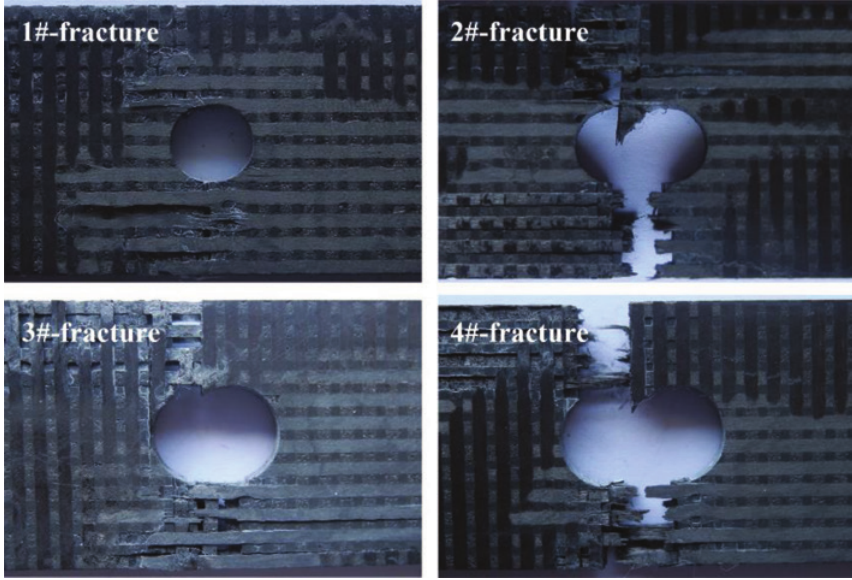
Figure 7: The final fracture patterns of different